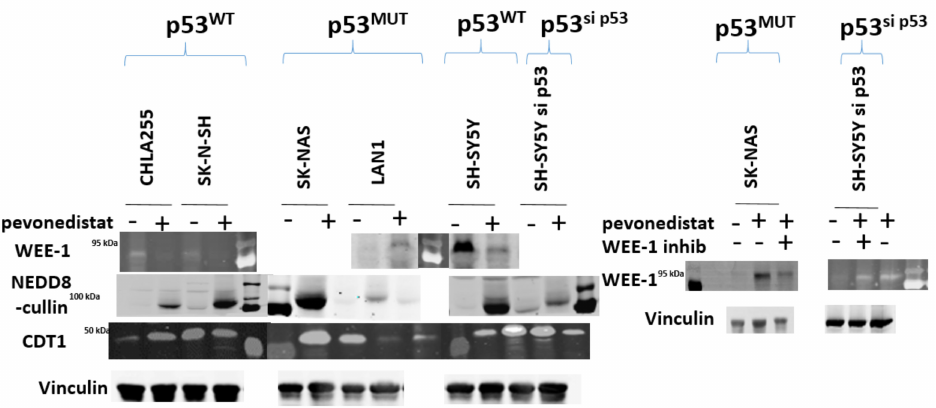
Figure 5. Immunoblot analysis of neuroblastoma cell lines after treatment with pevonedistat. p53 WT (cell lines CHLA255 and SKNSH), p53 MUT cell lines (SKNAS and LAN1), and p53 knockdown cell line (SH-SY5Y si -p53) were treated with pevonedistat at their IC50 for 48 h and protein expression was assessed for the proteins